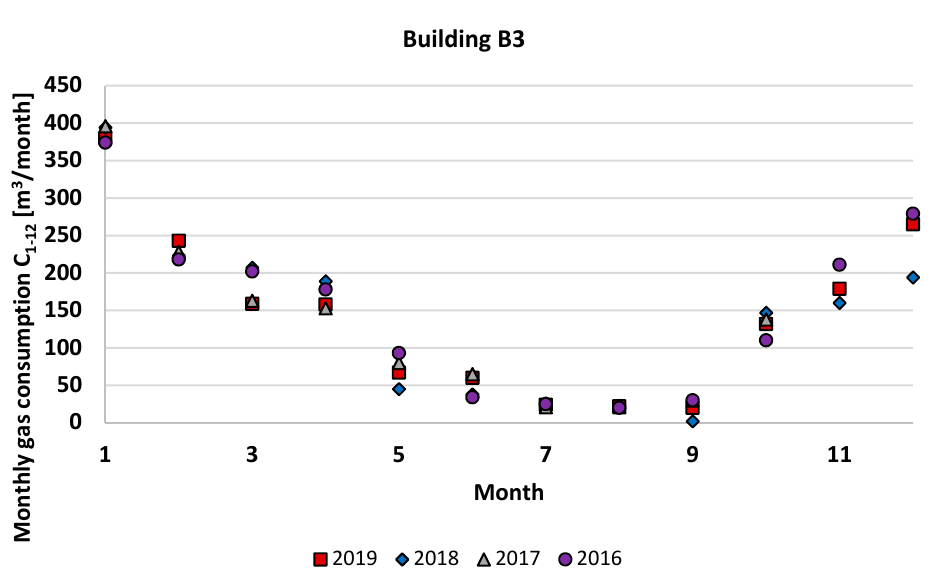
Figure 4. Monthly gas consumption in building B3. Table 2. Specifications of the three investigated